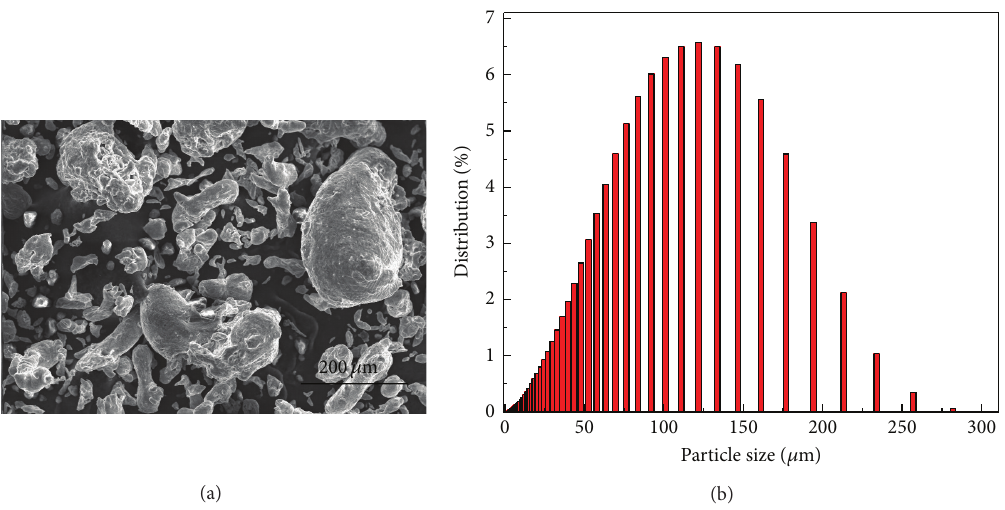
Figure 1: (a) Particle morphology and (b) particle size distribution of Alumix 431D